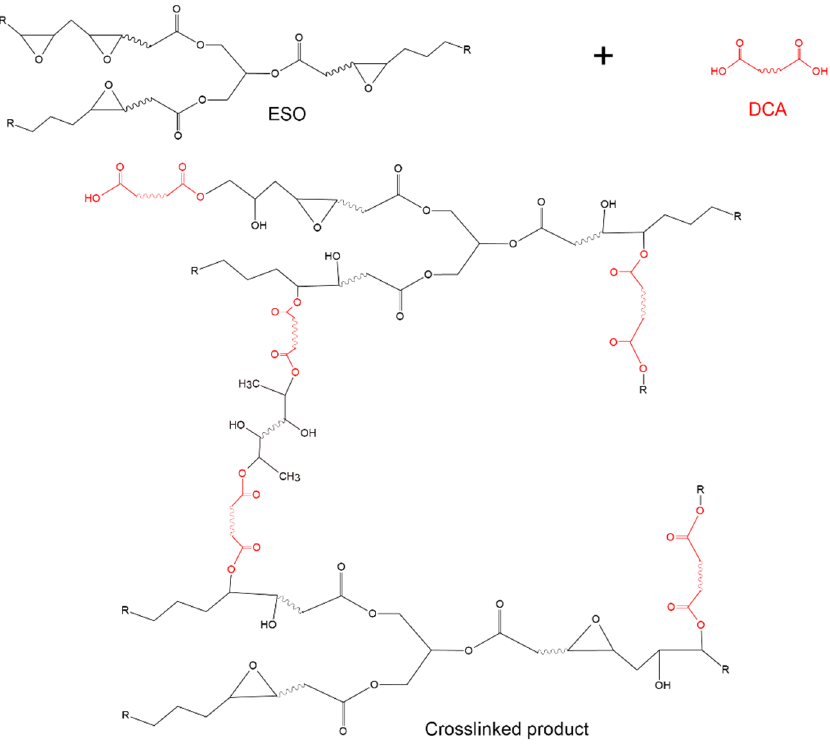
Figure 1. Scheme of reaction between ESO and DCA. A final branched structure can be observed.